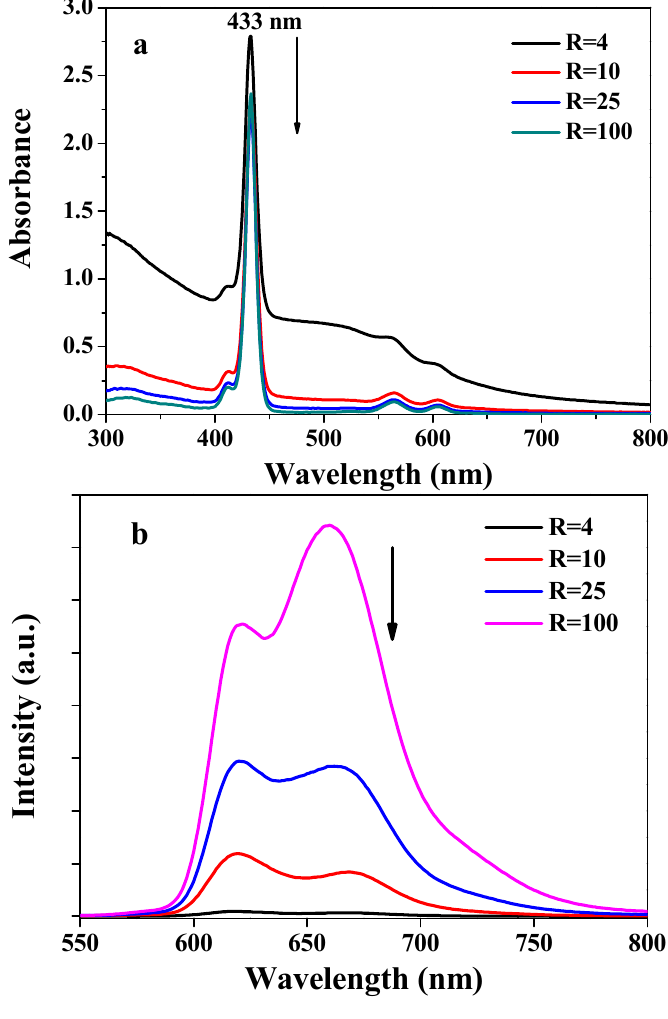
Figure 4. ( a ) UV-visible absorption spectra and ( b ) fluorescence emission spectra ( λ ext = 430 nm) of ZnTPPS and AuNPs in complex micelles with different R values (R = 100, 25, 10, and 4).